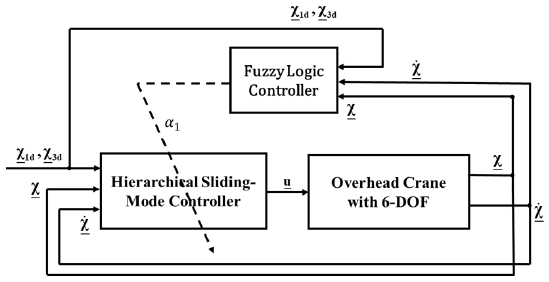
Figure 3. Control structure of adaptive fuzzy